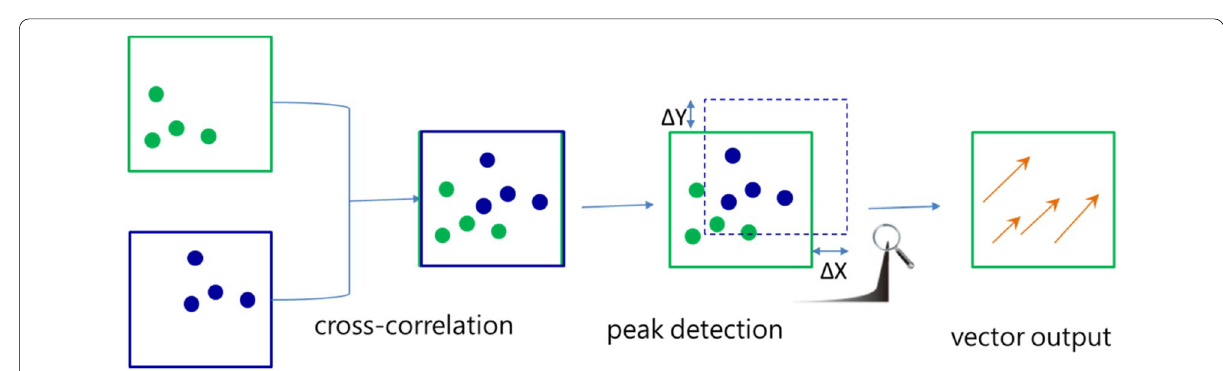
Fig. 9 Procedure of PIV’s